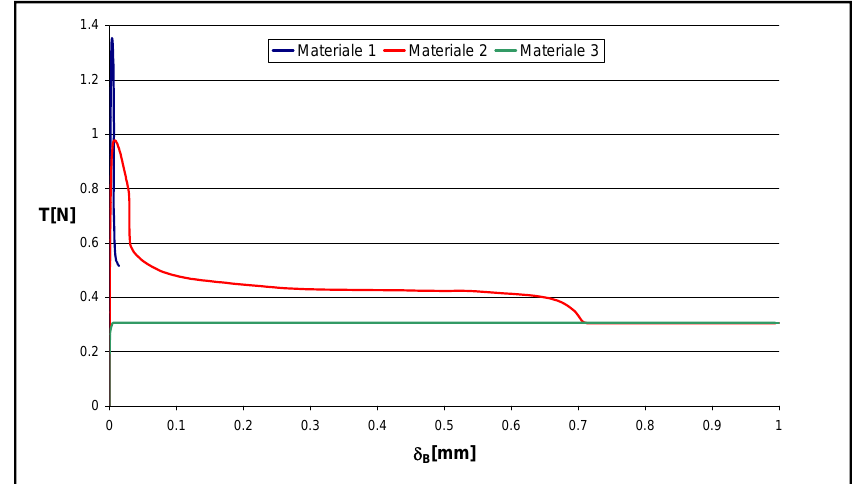
Figura 7: Forza orizzontale totale T in funzione della componente di spostamento  B